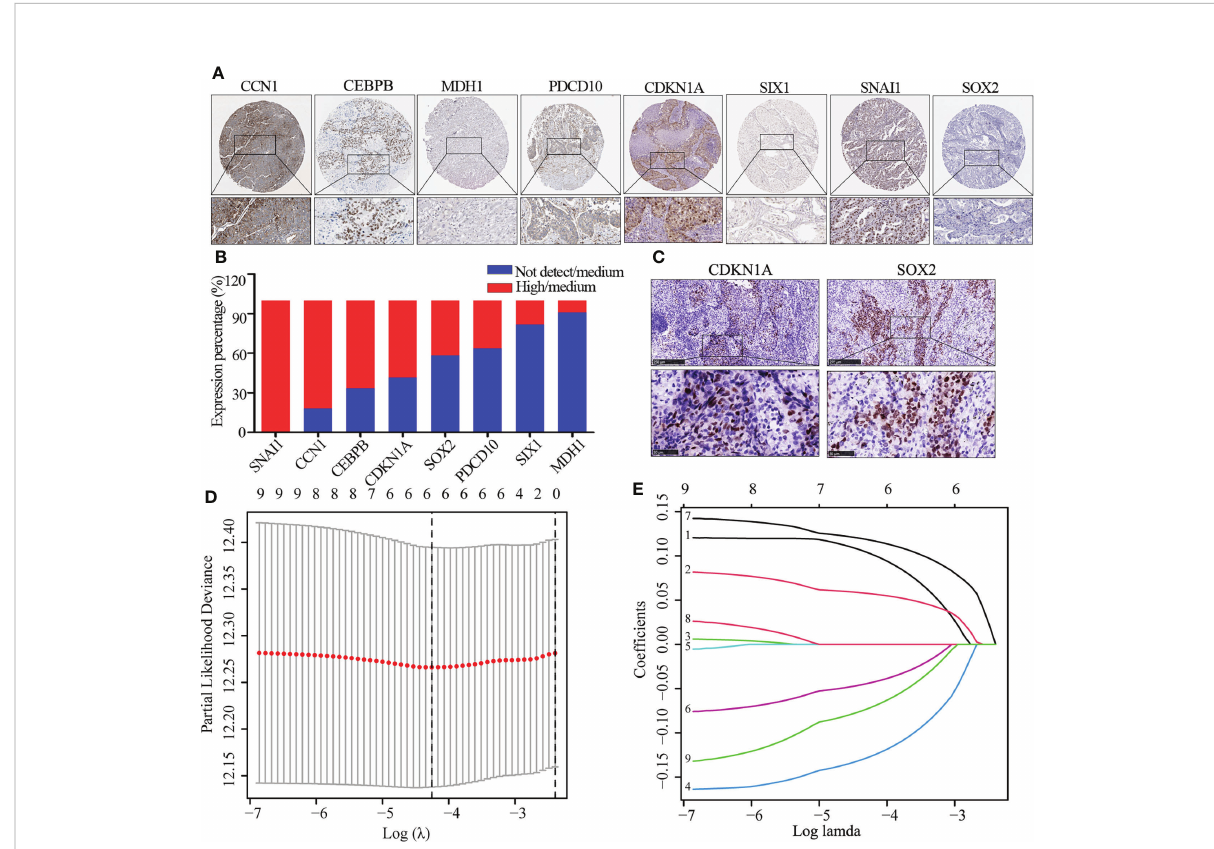
FIGURE 2 The expression of DEG and identi fi cation of hub gene. (A, B) Immunohistochemistry image of eight cellular senescence-related genes (A) and quantitative analysis (B) , the high and medium expression means positive expression and low and not detect means negative expression. (C) Immunohistochemistry image of CDKN1A and SOX2. (D) Regression of the six OS-related genes using LASSO. (E) In the LASSO regression, cross-validation is used to fi ne-tune the parameter